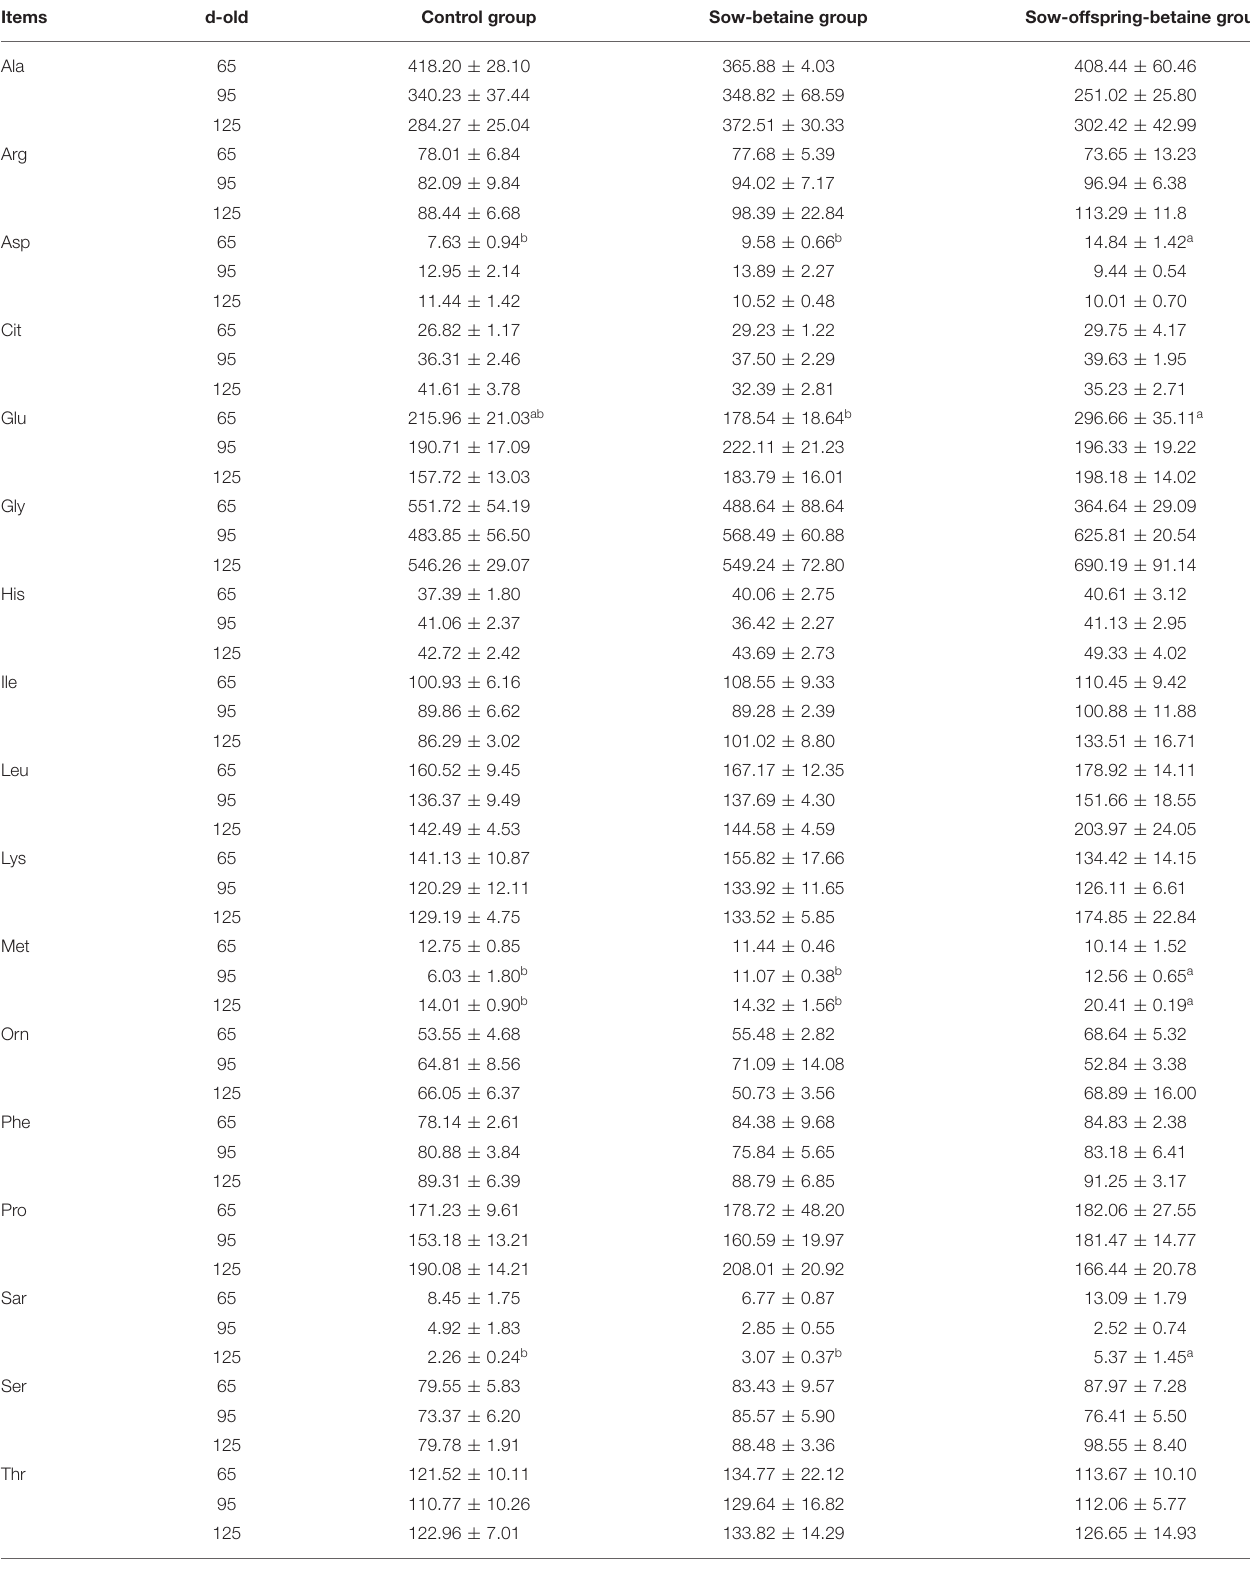
TABLE 4 | Effect of dietary betaine on plasma free amino acids of Bama mini-pigs ( µ mol L − 1 ).